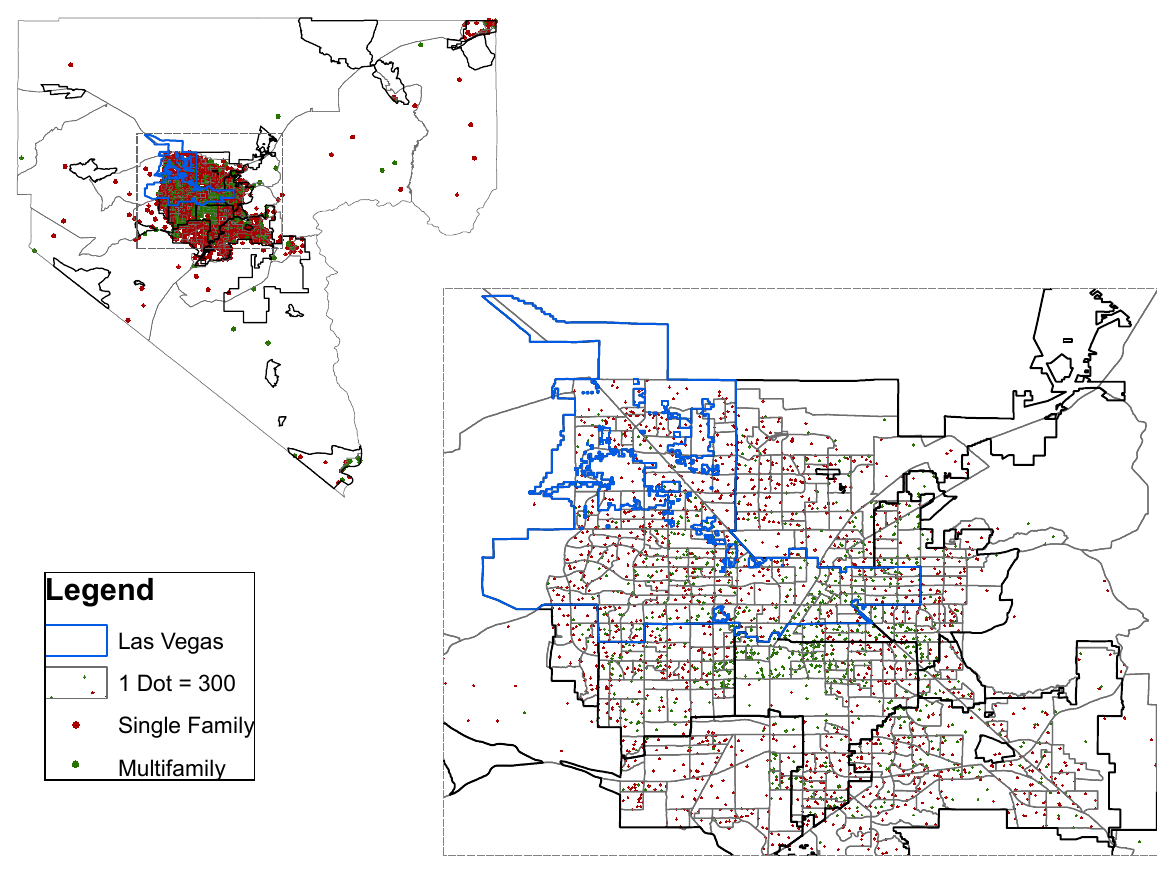
Figure 5: Single-family and multifamily housing units in the Las Vegas metropolitan area,